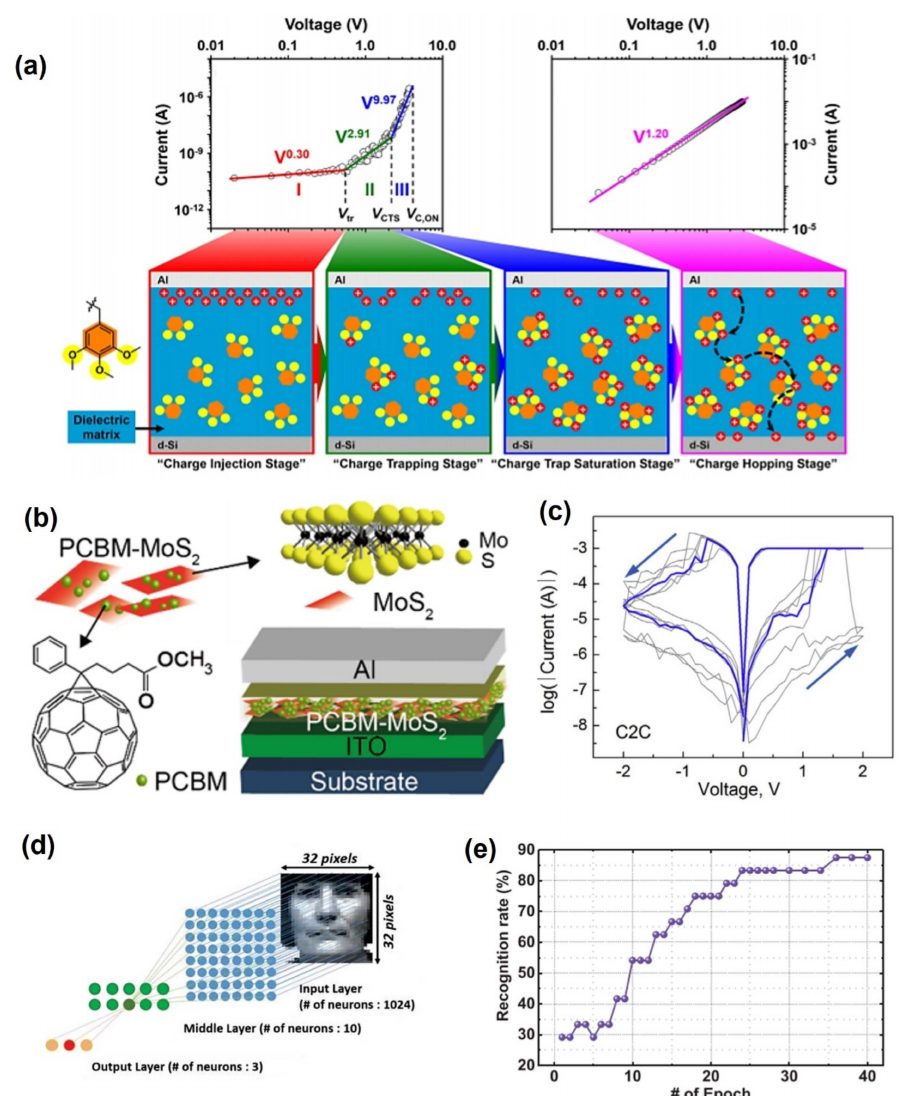
Figure 6. Classification of polymers according to the properties of the substances: ( a ) operation mechanism using oxygen- based polymers (adapted from [95] with permission from the American Chemical Society), ( b ) 2D material polymers (adapted from [97] with permission from the American Chemical Society), ( c ) conductive metal bridges (filaments) (adapted from [98] with permission from Elsevier), ( d ) realization memristor device using PVP (adapted from [99] with permission from the American Chemical Society), and ( e ) recognition rate by measuring the PVP memristor (adapted from [99] with permission from the American Chemical